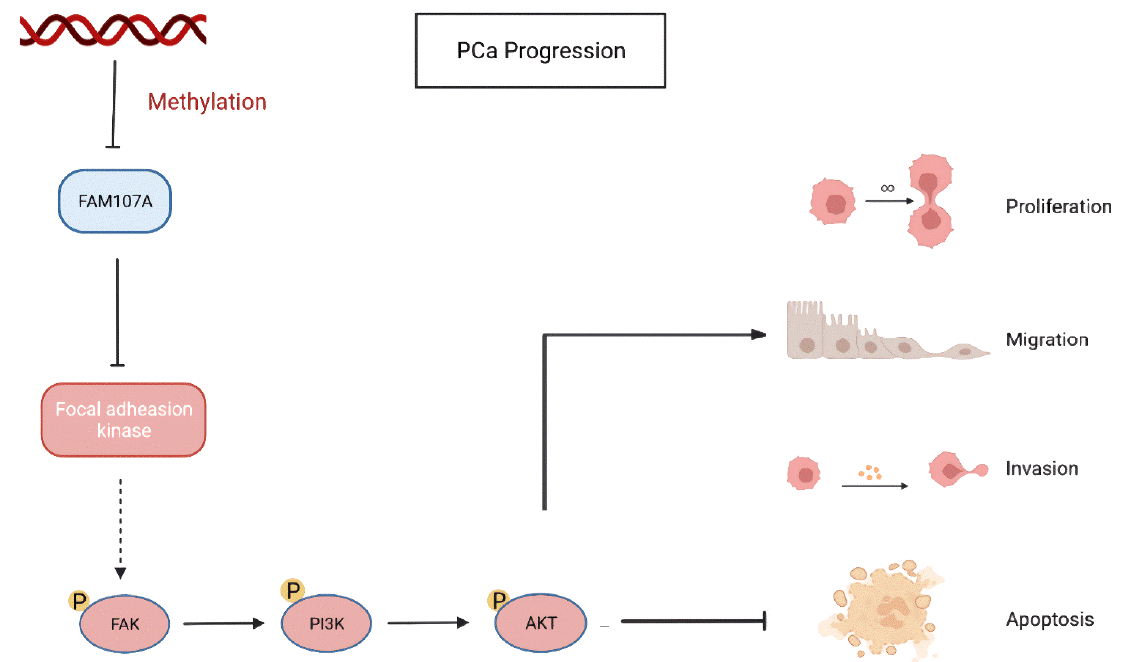
Figure 10. Inactivation of FAM107A associated with promoter methylation promotes prostate can- cer progression through the FAK/PI3K/AKT pathway.